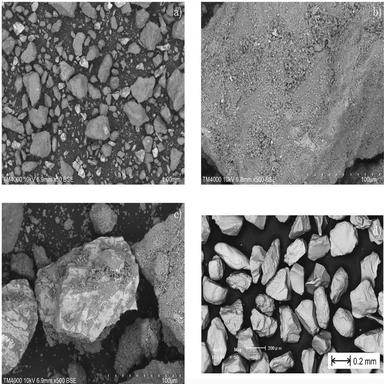
SEM images for the El Torito tailings sand (a), (b) and (c); and Toyoura sand (d) obtained from Kobayashi et al..